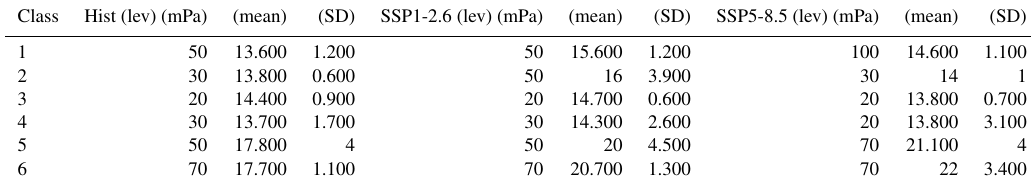
Table D1. Pressure level (lev) of the maximum value of class mean ozone concentration during DJF. The mean and standard deviation values of the class statistics are also shown (in mPa).